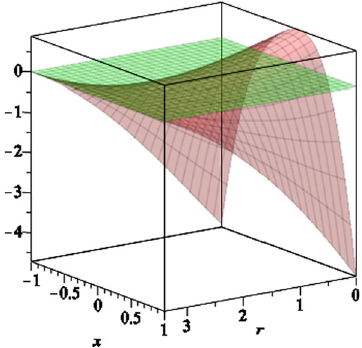
Fig. 3 The scaled function S ( r , x ) versus r ≥ r H and − 1 ≤ x ≤ 1, where we set the black hole parameters a = 6 , b = 2 , l = 1 , m = 7 and q = 1. The stationary limit surfaces r s ( x ) are the intersection of the curve S ( r , x ) with the horizontal plane at zero